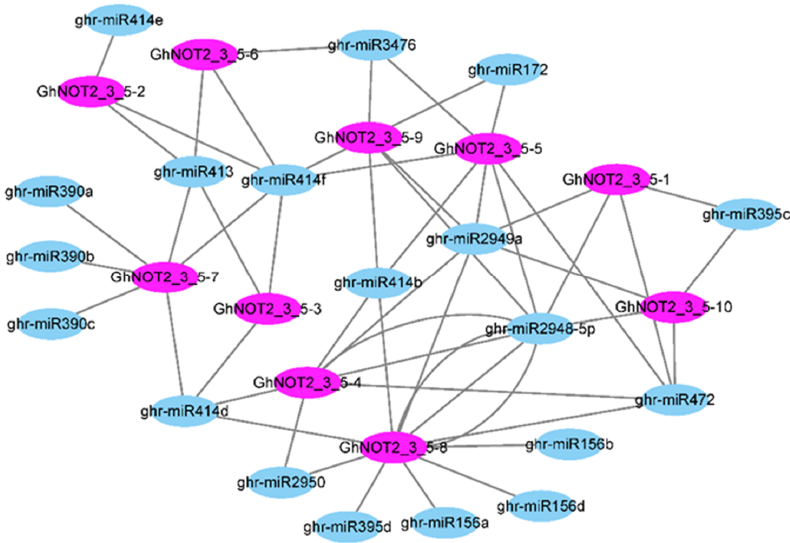
Figure 5. Prediction of miRNAs targeting GhNOT2_3_5 genes. Connections among nodes and lines indicate the targeting relationship of miRNA and GhNOT2_3_5 genes.